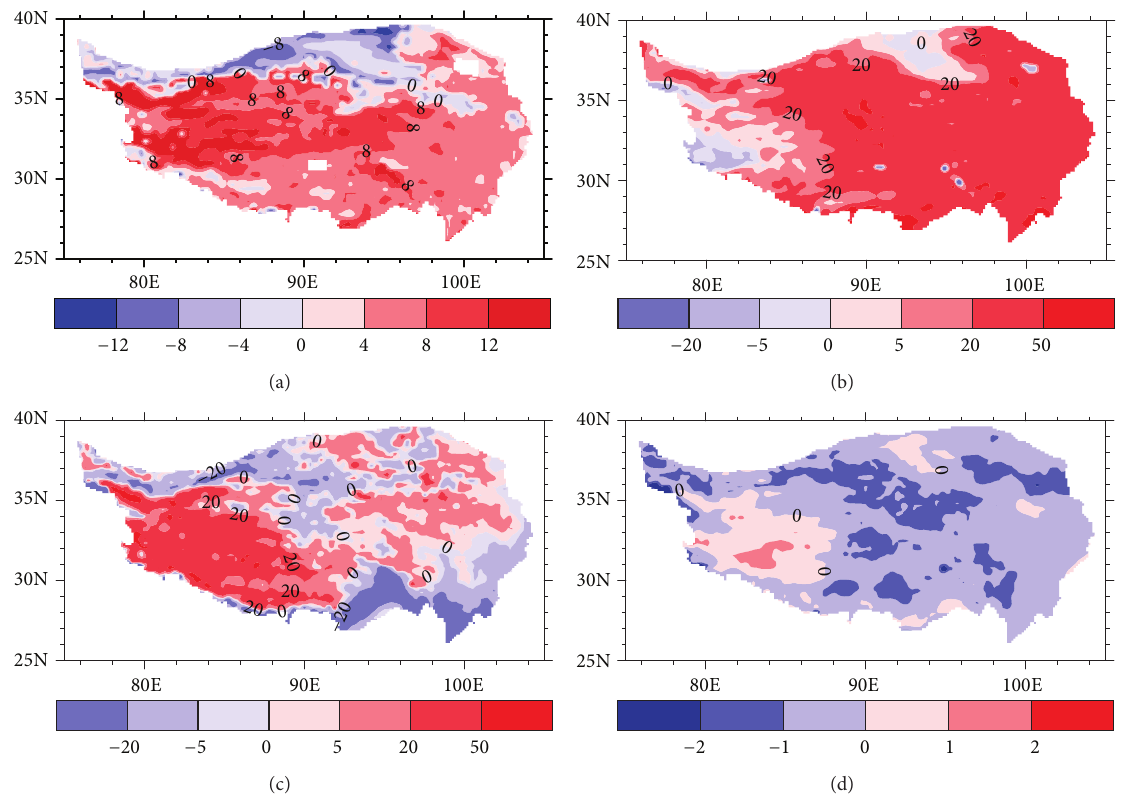
Figure 4: (a) The summer surface soil moisture difference between the BATS and CLM experiments (units: kg ⋅ m −2 ). (b) The same as (a) but for evapotranspiration (ET) (units: mm). (c) The same as (a) but for sensible heat flux (SHF) (units: W ⋅ m −2 ). (d) The same as (a) but for 2 m air temperature (units: ∘ C) during